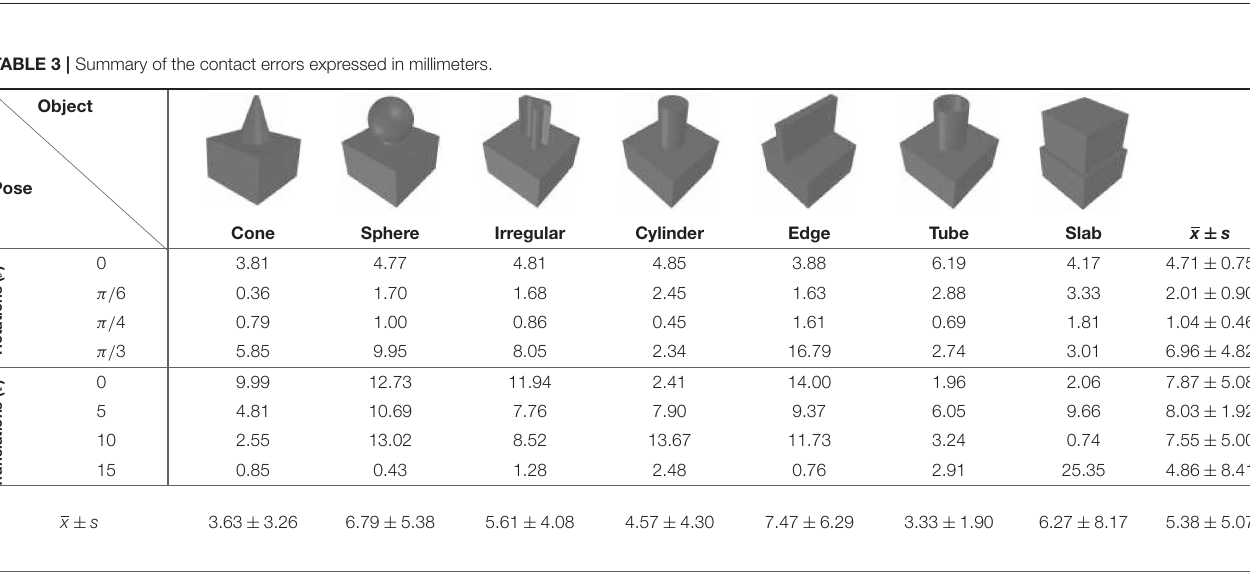
FIGURE 8 | (A) Two GelTip sensors are installed on a robotic actuator and a 3D-printed mount that holds a small 3D-printed shape (a cylinder here) placed on top of a wooden block. The actuator moves in small increments and collects tactile images annotated with the known contact positions. (B,C) Illustration of the motion of the sensor during the data collection. The sensor starts pointing downwards, as shown in (B) . To obtain contacts on the sensor surface, while moving, the sensor is also translated by ( 1 x , 1 z ), as shown in (C) . A total of eight contacts are collected per object: four rotations ( θ ) on the sensor tip and four translations ( τ ) on the sensor side, as highlighted in (B) .